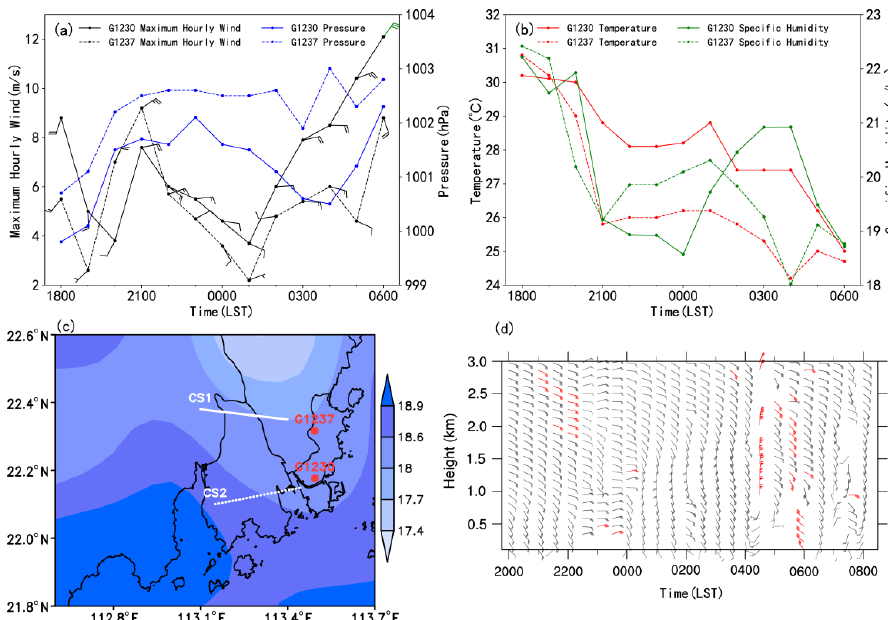
Figure 6. Time sequence diagram of meteorological elements of AWSs from 1800 LST on 31 May 2021 to 0600 LST on 1 June 2021. ( a ) Wind field and pressure; ( b ) Air temperature and specific humidity; ( c ) Specific moisture distribution. The solid line is the CS1 moving path. The dashed line is the CS2 moving path; ( d ) Zhuhai wind profiler from 2000 LST on 31 May 2021 to 0800 LST on 1 June 2021 (wind barbs, a full barb is 4 m s − 1 ; wind speed ≥ 12m s − 1 are marked in red, respectively).